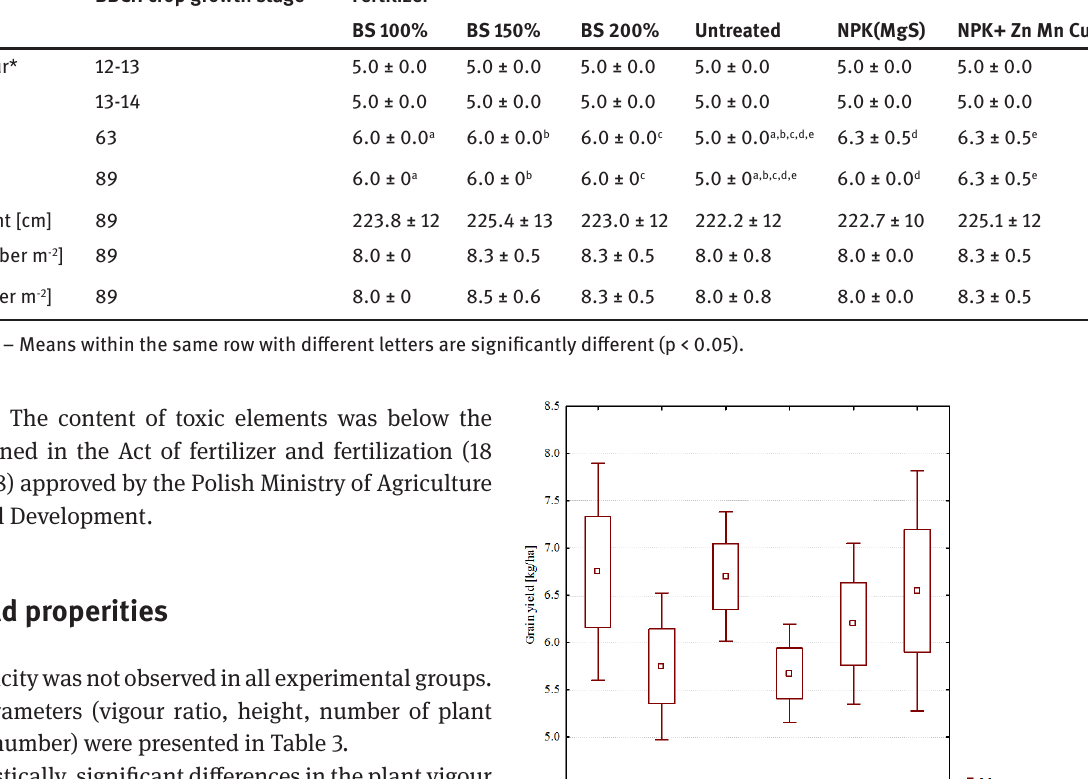
Table 4 and Fig. 2. Grain yield obtained for maize treated